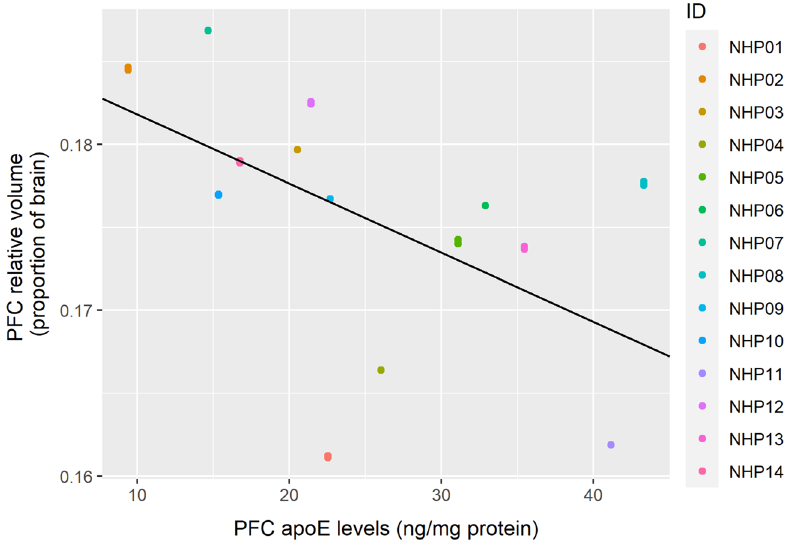
Figure 3. Levels of apoE in the PFC negatively predicts relative PFC volume. The figure shows results from a GEE model using PFC apoE as the sole predictor. Individual macaque IDs are distinctly colored.